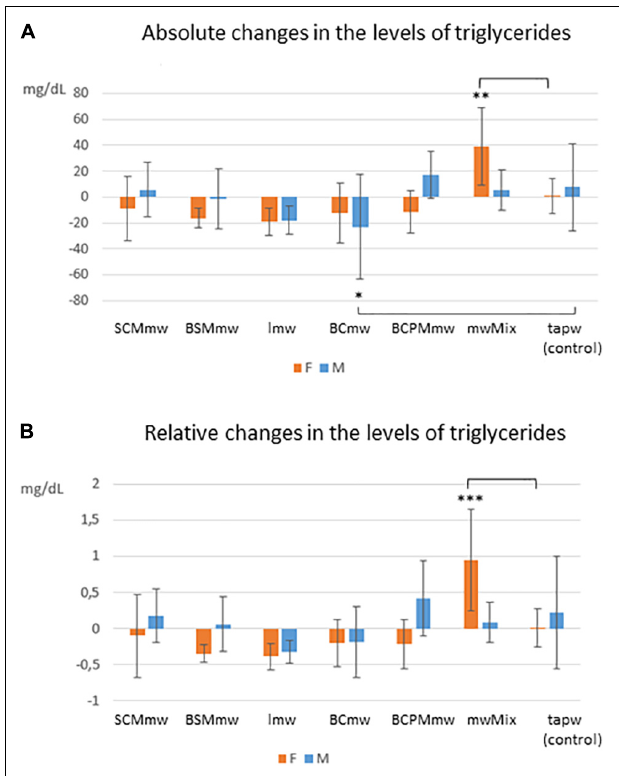
FIGURE 5 | Interaction effect of sex and treatment on triglycerides among treated mice. The figure shows average absolute (T6–T4; A ) and relative (T6–T4/T4; B ) differences ± SDs in triglyceride levels among mineral water-treated mice and tap water-treated controls. The groups are: SCMmw, sulphate-, calcium-, and magnesium-rich mineral water; BSMmw, bicarbonate-, sulphate-, and magnesium-rich mineral water; lmw, light mineral water; BCmw, bicarbonate- and calcium-rich mineral water; BCPMmw, bicarbonate-, calcium-, potassium-, and magnesium-rich mineral water; mwMix, alternation of NMWs; tapw, low mineral content tap water. Between-group analysis by two-way ANOVA was performed to determine the effects of sex, treatment, and the interaction between the two, followed by Dunnett’s test comparing each group against the control group. * P ≤ 0.05, ** P ≤ 0.01, and *** P ≤